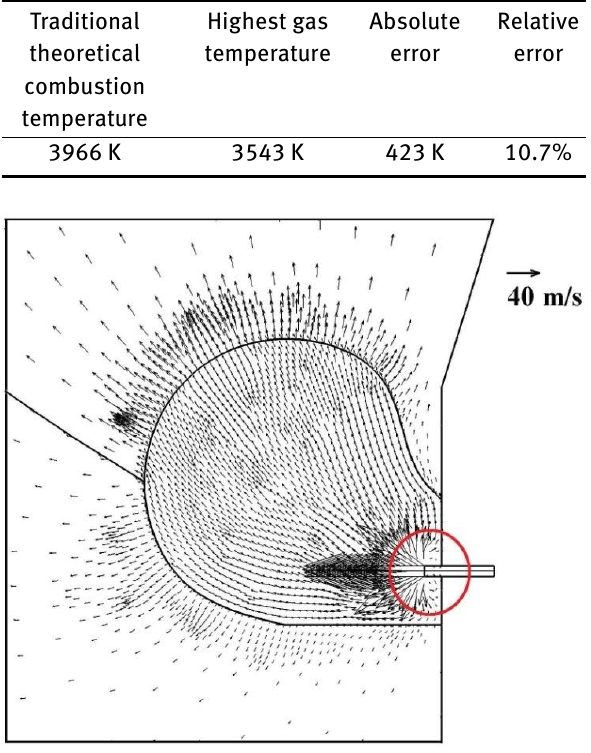
Figure 2: Gas phase velocity vector around raceway